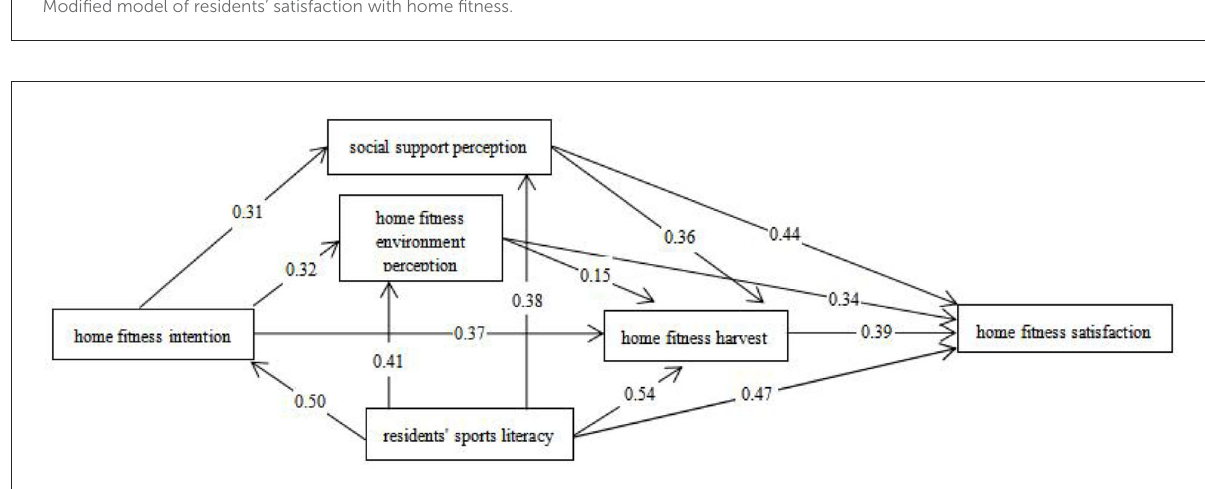
FIGURE3 Satisfaction model of residents’ home